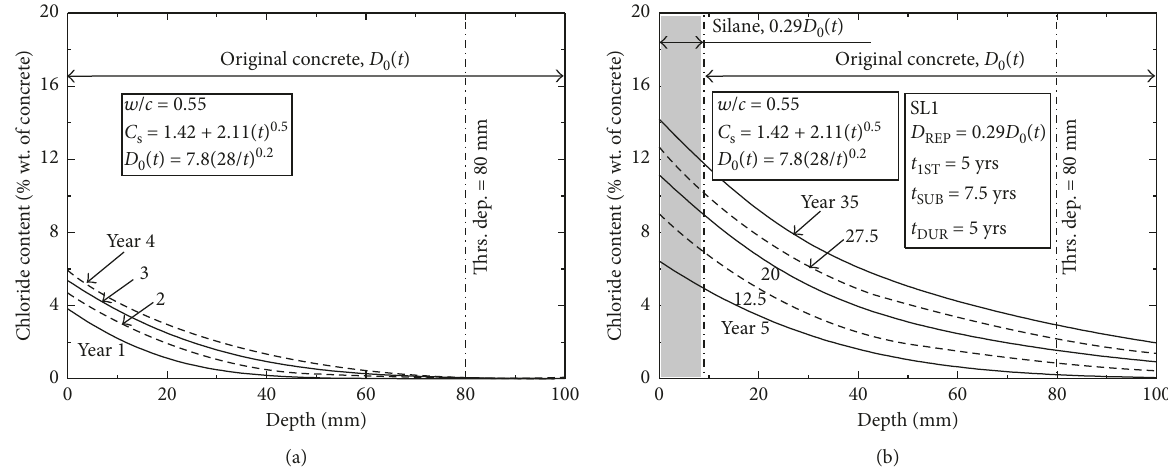
Figure 5: Chloride content versus depth for original concrete of w / c � 0.55 with SL1. (a) Years 1 to 4 (before silane treatment). (b) Year 5 to year 35 (with silane treatment).